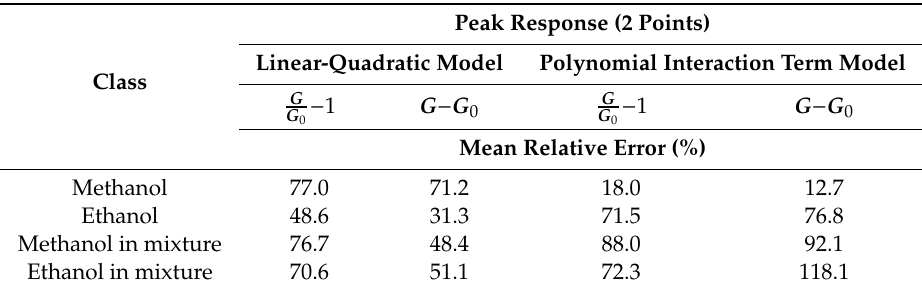
Table 3. Prediction results of the dynamic response with different variables.